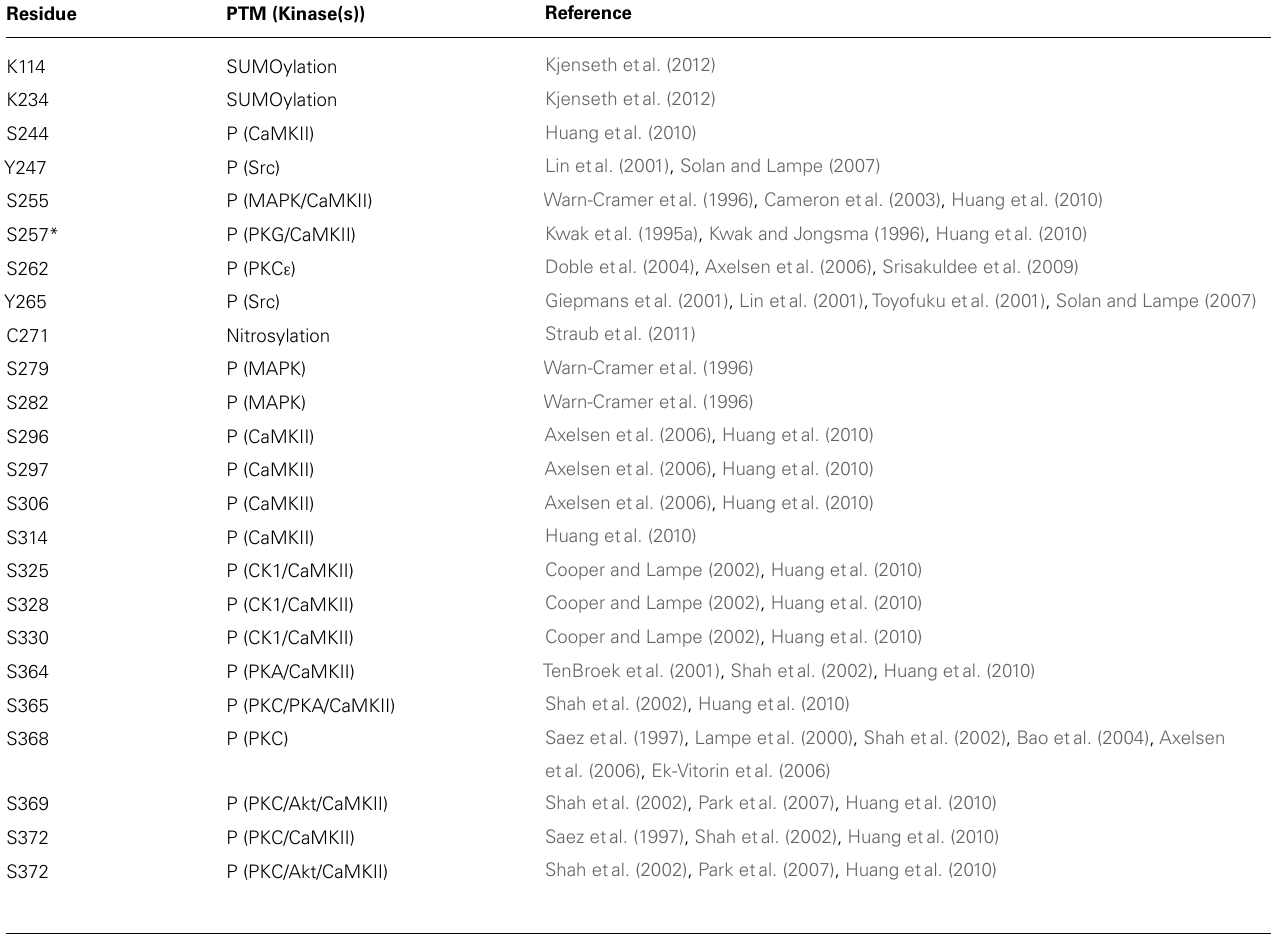
Table 2 | Connexin 43 post translational modification (PTM) sites including kinases responsible for phosphorylation (P).